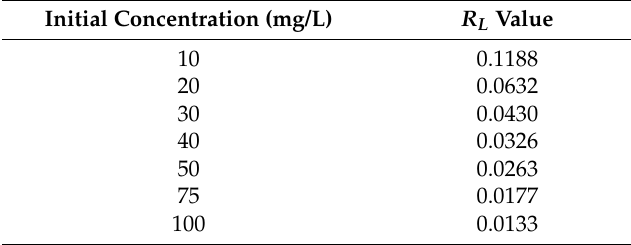
Table 7. The values of R L for the adsorption of Se(IV) by the nZVI/rGO composites.